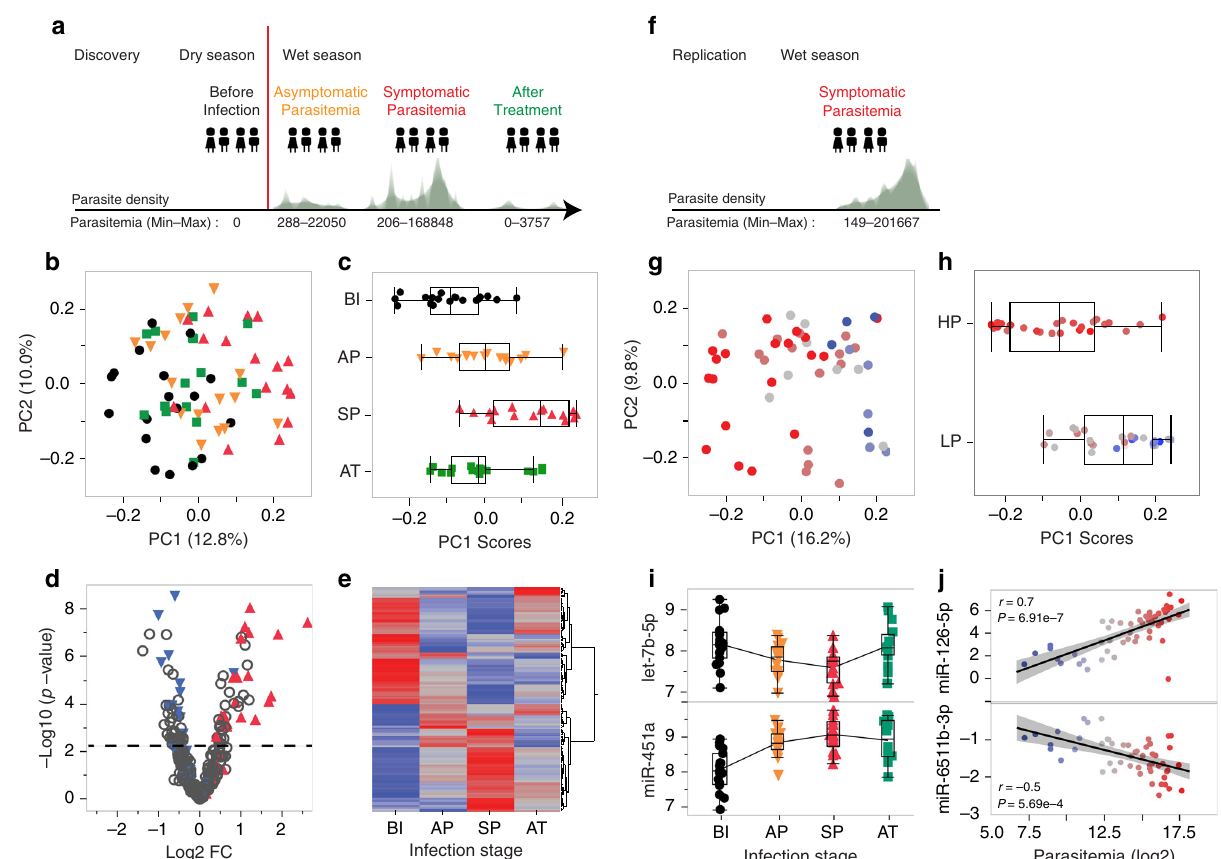
Fig. 1 Study design and dynamics of global miRNAs expression pro fi ling in malaria. a Study design and infection stages pro fi led in the discovery phase: Before Infection ( n = 19), Asymptomatic Parasitemia ( n = 16), Symptomatic Parasitemia ( n = 17), and After Treatment ( n = 16). Parasite density plots and the range of parasitemia (minimum and maximum number of parasites per µ l of blood) in each stage are shown. b PCA of the miRNA transcriptome in the discovery set ( n = 68). c PC1 scores of the four stages of infection in the discovery set (n = 68): BI ( n = 19), AP ( n = 16), SP ( n = 17), and AT ( n = 16). d Volcano plot of differential miRNA expression between the SP ( n = 17) and BI ( n = 19) groups. The magnitude (log2 fold change; x axis) and statistical signi fi cance ( − log10 P ) of differential expression of individual miRNA derived from repeated measures analysis of covariance (see Methods). The horizontal line indicates the − log10 P corresponding to B-H FDR 5%. Seventy-two miRNAs either positively (labeled in red) or negatively (labeled in blue) correlated with parasitemia in the replication set ( n = 53, multiple regression) are highlighted. e Hierarchical clustering of the standardized least square means of 127 differentially expressed miRNAs across the four stages of infection (repeated measures analysis of covariance, B – H FDR 5%.). f Parasite density plot and the range of parasitemia (minimum and maximum number of parasites per µ l of blood) in the replication set (Symptomatic Parasitemia; n = 53) are shown. g PCA of the miRNA transcriptome in the replication set ( n = 53). The color gradient (blue to gray to red) indicates levels of log2 parasitemia (from low to high). h PC1 scores for the high parasitemia (HP; n = 26) and low parasitemia (LP; n = 27) groups. High and low parasitemia is determined based on the log2 parasitemia median value of 14.8. i Expression values of let-7b-5p and miR-451a across the four stages of infection: BI ( n = 19), AP ( n = 16), SP ( n = 17), and AT ( n = 16). j Correlation between expression values of miR-126-5p and miR-6511b-3p, and log2 parasitemia (n = 53) adjusting for sex, age and white blood cell count (multiple regression). Pearson correlation coef fi cient ( r ) and P values for miR-126-5 ( r = 0.7, B – H P = 6.91e-7) and miR-6511b-3p ( r = − 0.5, B – H P = 5.69e-4) are shown. The 95% con fi dence interval of the line of best fi t is shown in shaded gray. The data presented within each condition (discovery set: BI, AP, SP, and AT; replication set) are from biologically independent samples. In the discovery set, the data is from repeated measurements as shown in Supplementary Data 1. The box plots in c , h , and i show the median, the 25th and 75th percentiles as box edges, and the 5th and 95th percentiles as bounds of